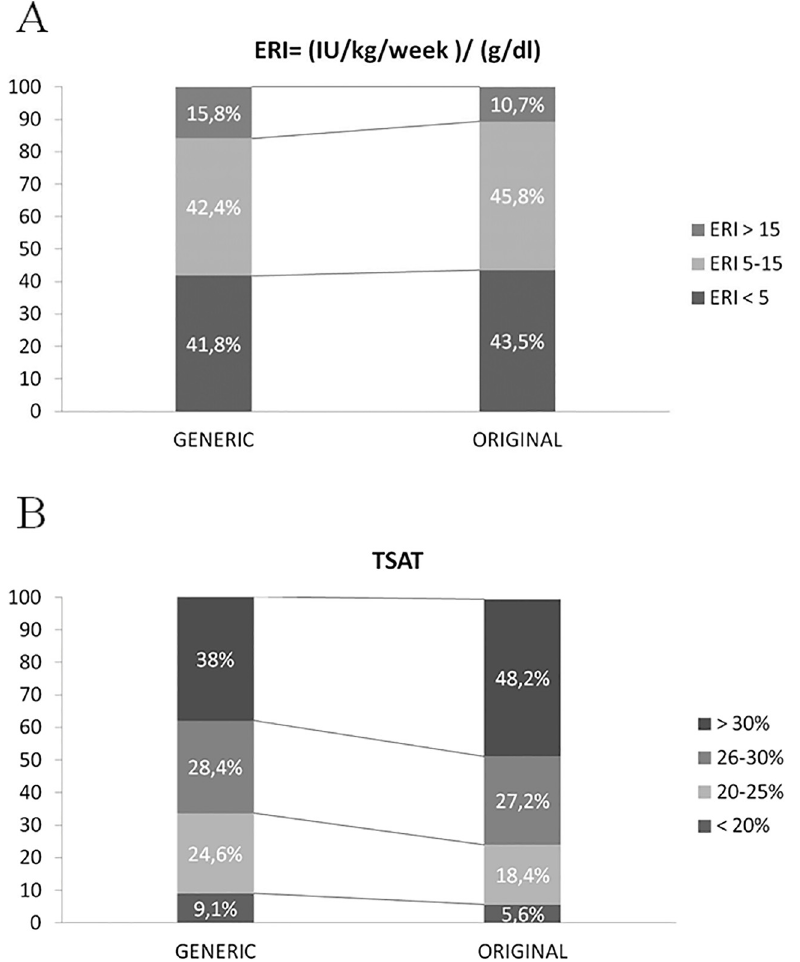
Fig 4. Distribution of the population depending on ERI (4A) or TSAT levels